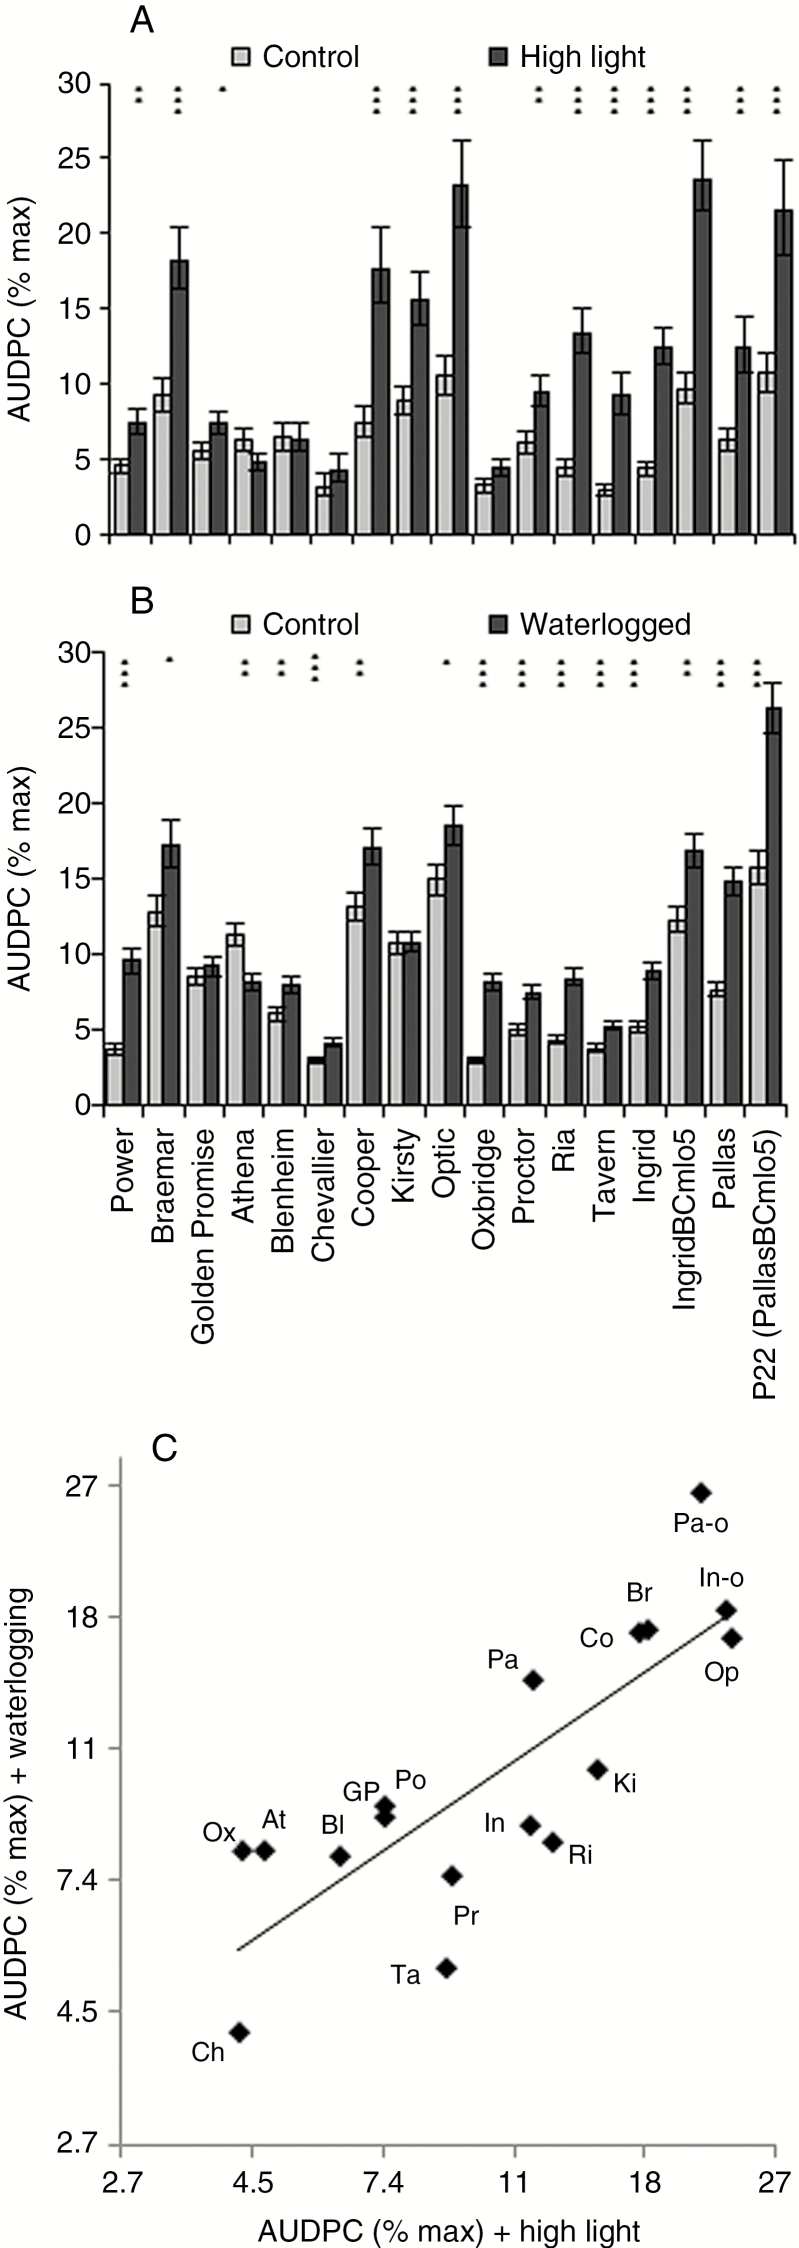
Effect of abiotic stress on Ramularia leaf spot development. Different spring barley varieties were grown under high light conditions (A) or waterlogged for 6 d (B) before inoculation with Ramularia collo-cygni. Disease development on abiotic stress-treated plants (dark grey bars) was compared with control plants (light grey bars) grown under normal controlled-environment room conditions. Disease is expressed as the area under the disease progress curve (AUDPC). Data were analysed by general linear modelling. ***P < 0.001; **0.001 < P < 0.01; *0.01 < P < 0.05 for comparisons between stress-treated and control plants. (C) Comparison of varieties’ disease scores under the two abiotic stresses. Codes are the first two letters of the varieties’ names; In-o, Pa-o: mlo5 near-isogenic lines of Ingrid and Pallas, respectively. Error bars indicate ± 1 s.e.